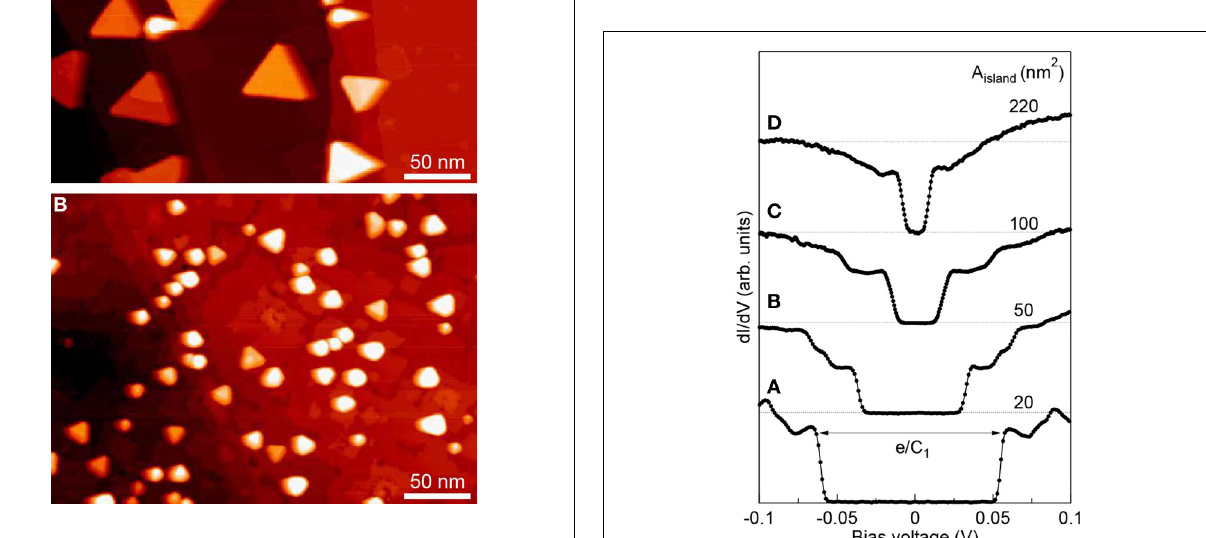
FIGURE 2 | STM topographies acquired on two different samples with Pb islands grown on NaCl/Ag(111). Pb islands are visible in both images, most of them with triangular shape and a few with rounded shape. The smaller island size in (B) as compared to (A) is obtained on a NaCl film exhibiting more defects. (A) : + 1V, 20pA; (B) : + 4V, 20pA.